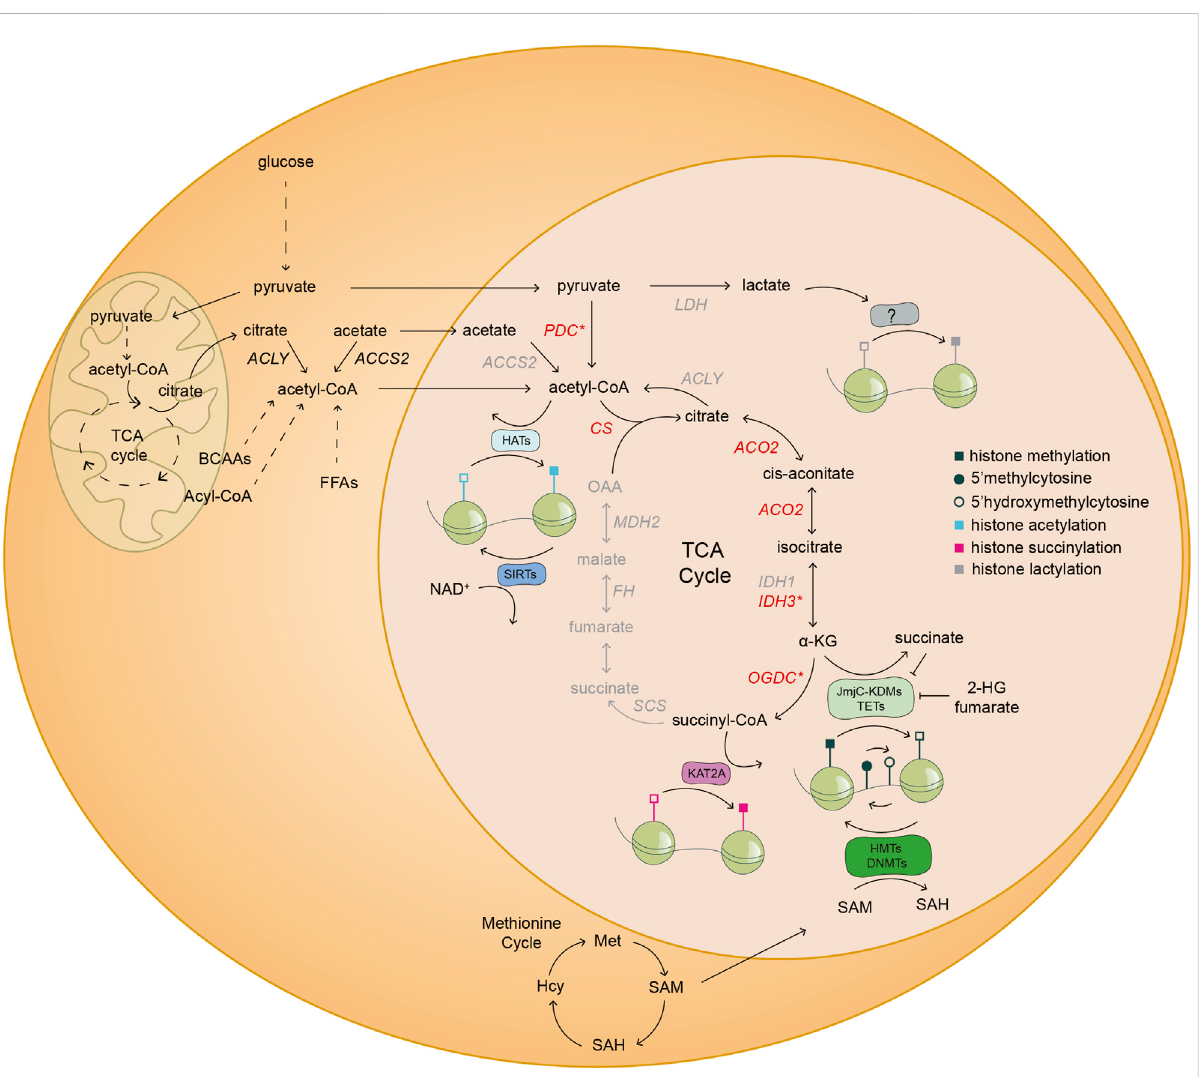
FIGURE 2 Nuclear metabolism shapes the cellular chromatin landscape. Schematic illustration of the coupling of nuclear metabolism with epigenetics. The existence of a nuclear metabolic sub-network of the TCA cycle (black) and nuclear localization of distinct metabolic enzymes (red) have been reported in mouse embryos and/or mESCs. The asterisk (*) denotes that at least one of the subunits of the highlighted enzymatic complexes are found inside the nucleus of mouse embryos and/or mESCs. Speci fi cally, PDH in the case of PDC; IDH3G from the IDH3 complex; and OGDH subunit from the OGDC. The other half of the TCA cycle and several other metabolic enzymes (grey) have only been described in the nucleus of cancer cells. The TCA cycle metabolite α -KG is a co-factor and substrate of JmjC-KDMs and TETs, which are histone lysine demethylases and DNA demethylases, respectively. Conversely, other TCA cycle intermediates, such as fumarate and succinate, and the metabolite 2-HG, are inhibitors of JmjC-KDMs and TETs. SAM derived from one carbon metabolism is a cofactor of HMTs and DNMTs, which add methyl groups to histone lysine residues and DNA, respectively. The complex OGDC catalyzes the conversion of α -KG to succinyl-CoA, which is used by KAT2A to succinylate speci fi c histone residues in cancer cells. Acetyl-CoA derived from various metabolic reactions is used by HATs to transfer acetyl groups to histones. On the contrary, SIRTs consume NAD + to deacetylate histone residues. Finally, lactate derived from anaerobic glycolysis might be used by yet undescribedepigeneticmodifyingenzymes,forhistonelactylation.ACCS2,acetyl-CoAsynthetase2;ACLY,ATP-citratelyase;ACO2,aconitase2; α - KG, alpha-ketoglutarate; BCAAs, branched-chain amino acids; CS, citrate synthase; DNMTs, DNA methyltransferases; FFAs, free fatty acids; FH, fumarate hydratase; HATs, histone acetyltransferases; Hcy, homocysteine; IDH1, isocitrate dehydrogenase 1; IDH3G, isocitrate dehydrogenase 3 subunit G; JmjC-KDMs, Jumonji C-domain lysine demethylases; KAT2A, lysine acetyltransferase 2A; KMTs, lysine methyltransferases; LDH, lactate dehydrogenase; MDH2, malate dehydrogenase 2; Met, methionine; NAD + , nicotinamide adenine dinucleotide; OAA, oxaloacetate;